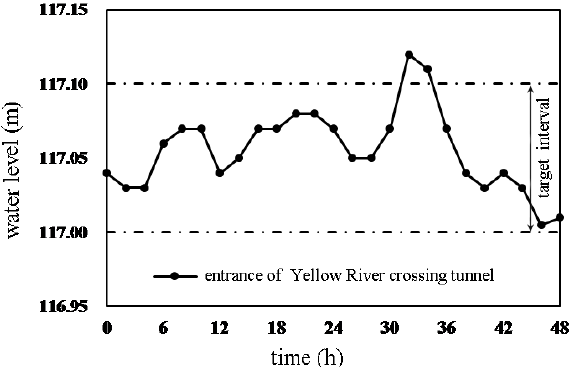
Figure 8. Variation of water level at the entrance of Yellow River crossing tunnel.